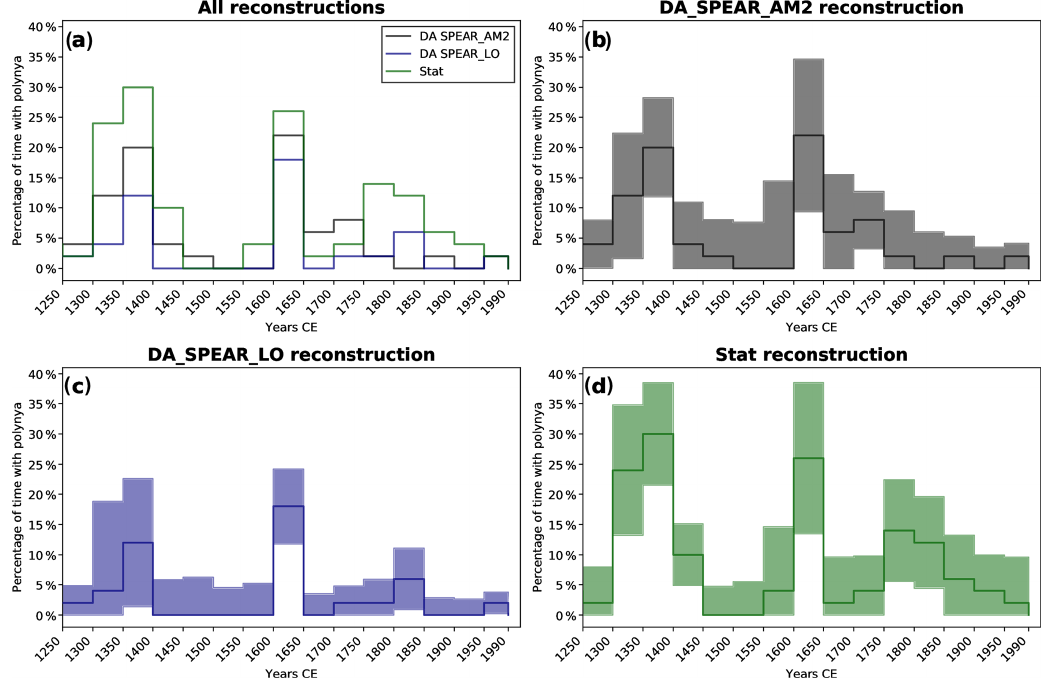
Figure 9. (a) Percentage of the years with the index of polynya activity higher than 0.8 per 50-year time interval in the reconstructions using data assimilation with SPEAR_AM2 (DA SPEAR_AM2 black), data assimilation with SPEAR_LO (DA SPEAR_LO, blue) and a simple average of standardized time series (Stat, green). Percentage of the years with the index of polynya activity higher than 0.8 with the uncertainties estimated from the standard deviation of the seven reconstructions using six and all of the combinations of five different records for the reconstruction using (b) data assimilation with SPEAR_AM2, (c) data assimilation with SPEAR_LO and (d) a simple average of standardized time